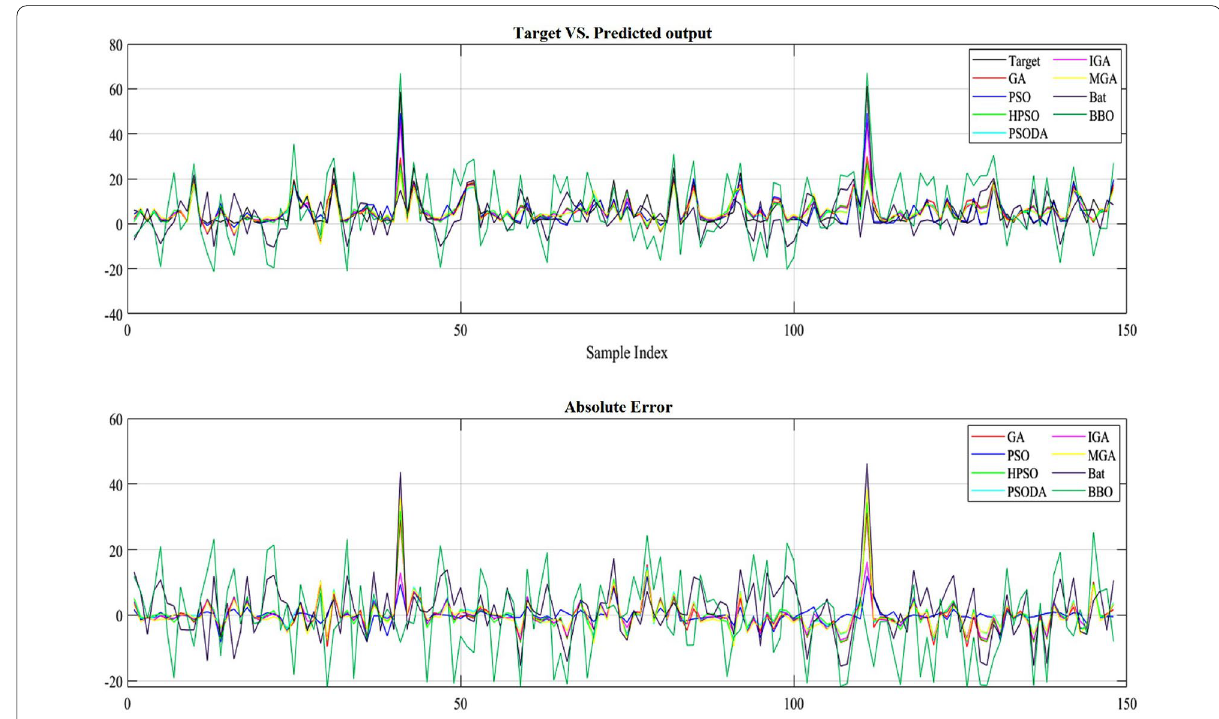
Fig. 12 Performance and absolute error of various approaches through testing dataset.